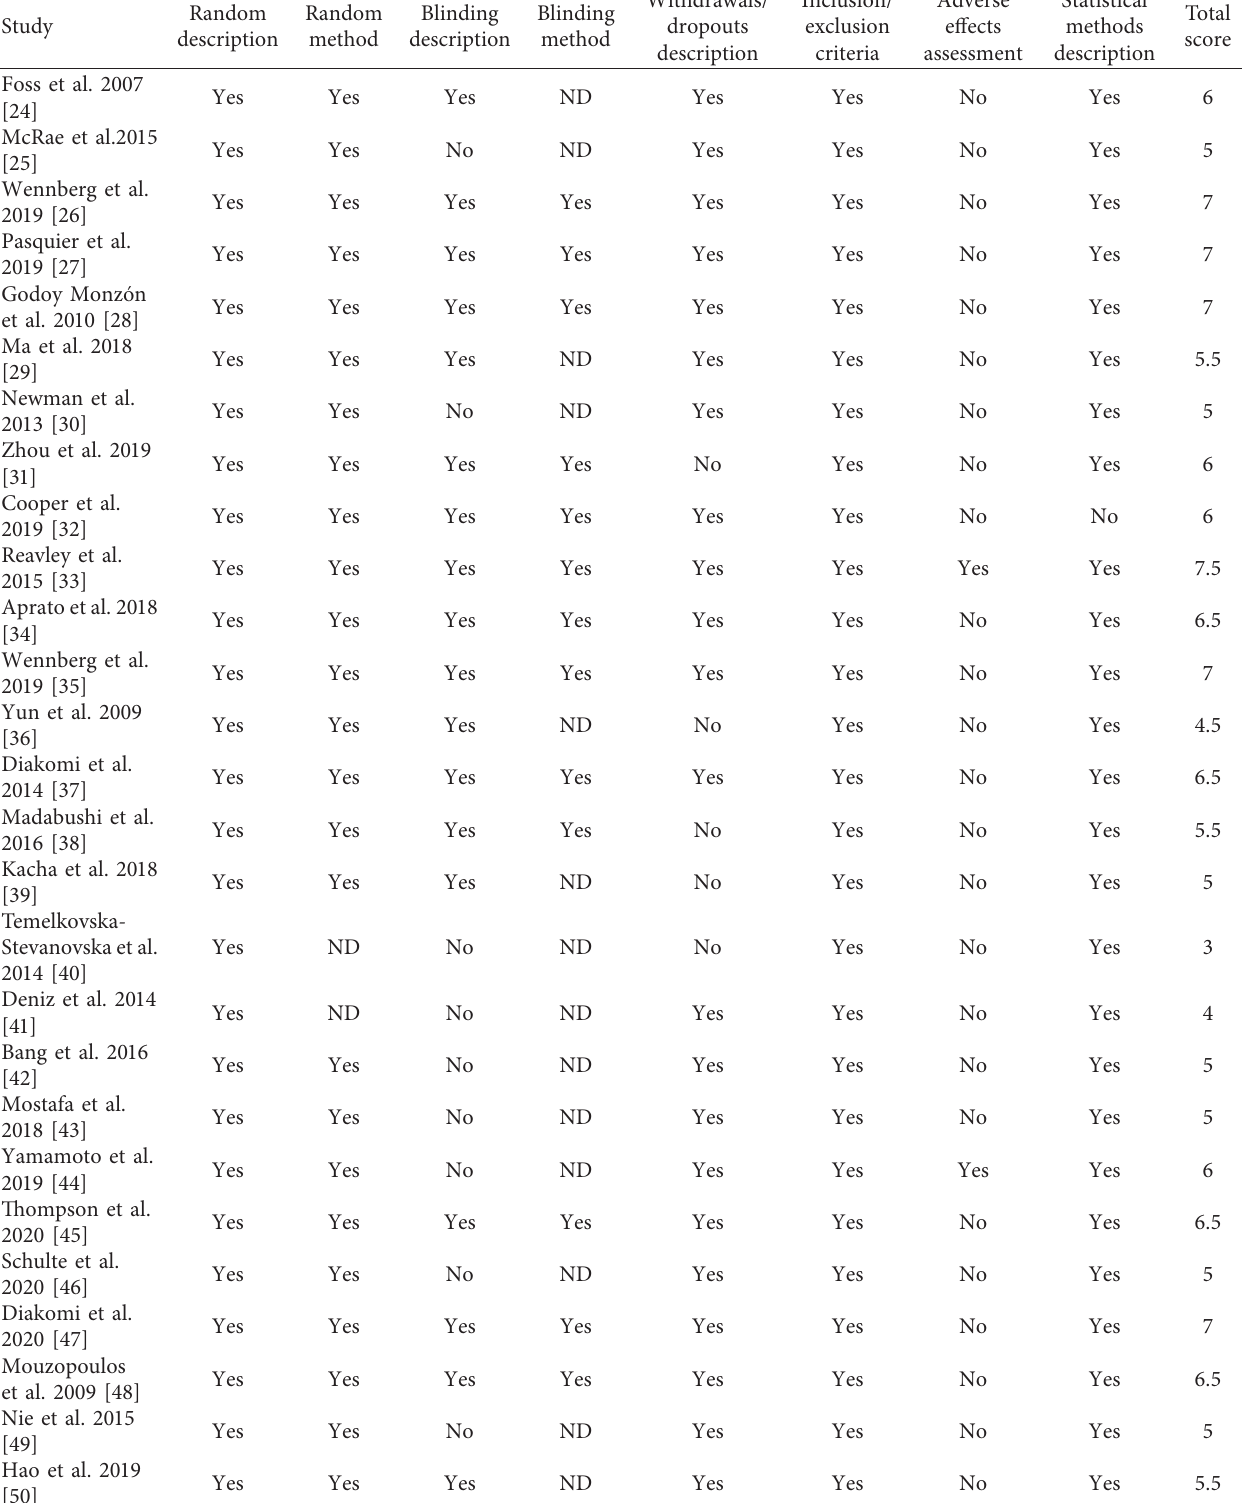
Table 2: Methodological assessment of the RCTs